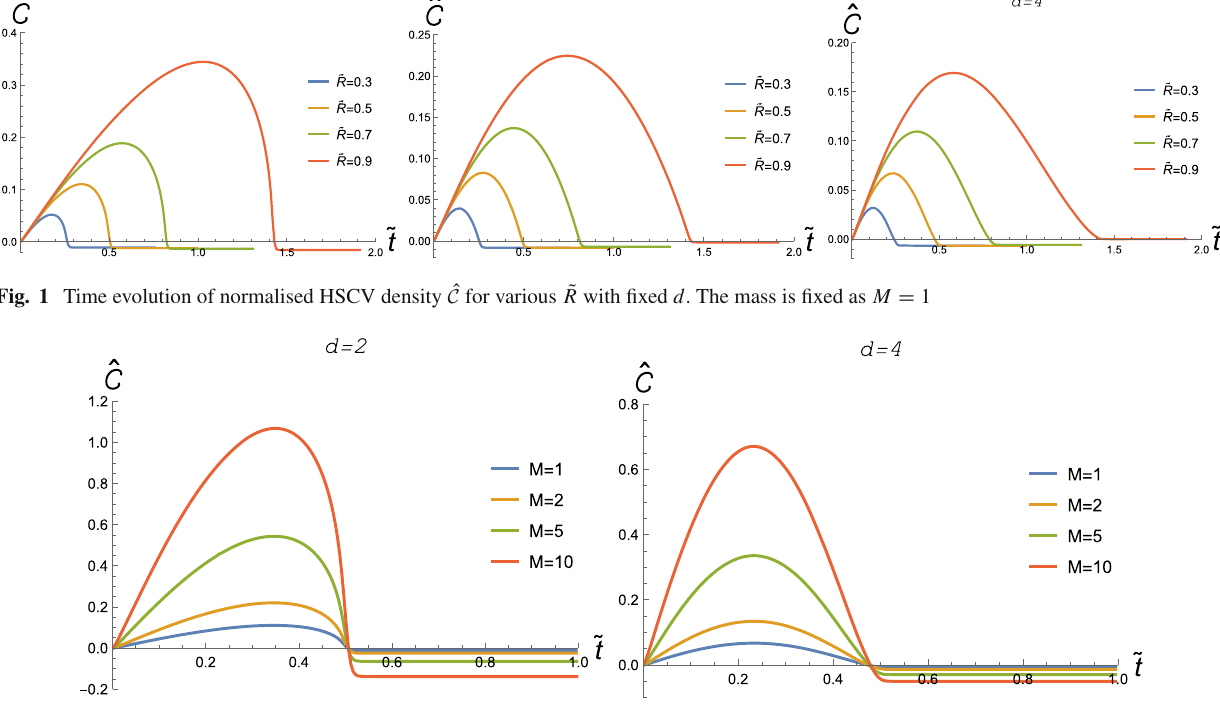
Fig. 2 Time evolution of normalised HSCV density ˆ C for various M with fixed d . The subregion size is fixed as ˜ R = 0 .